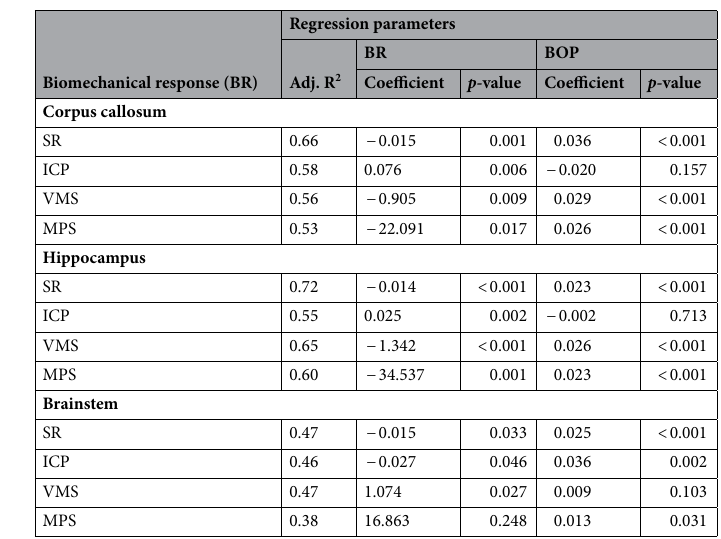
Table 1. Regression models to assess the correlation between experimentally observed changes in glial fibrillary acidic protein (GFAP) and computationally predicted biomechanical responses in the rat brain due to a single head-only blast-wave exposure. Adj. R 2 adjusted R-squared, BOP blast overpressure, ICP intracranial pressure, MPS maximum principal strain, SR strain rate, VMS von Mises